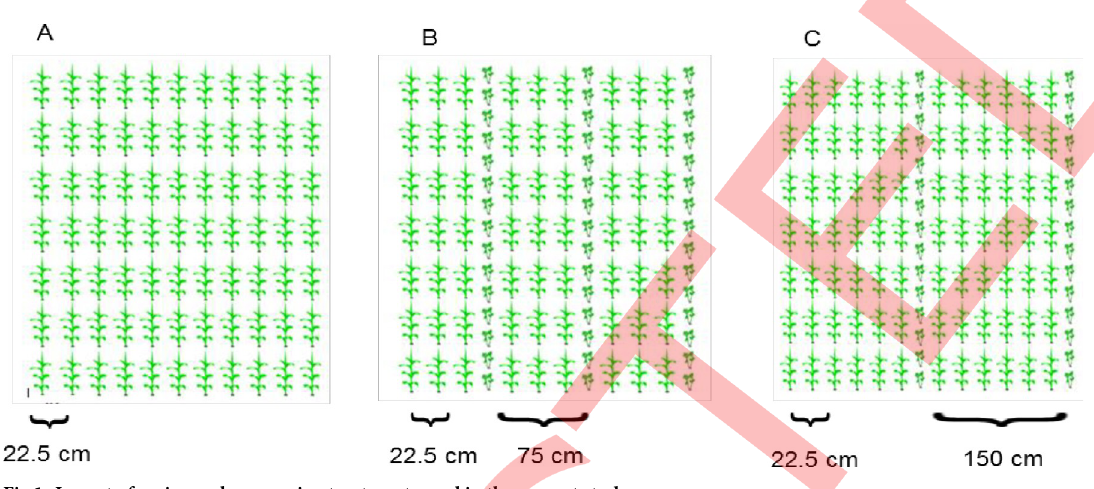
Fig 1. Layout of various relay cropping treatments used in the current